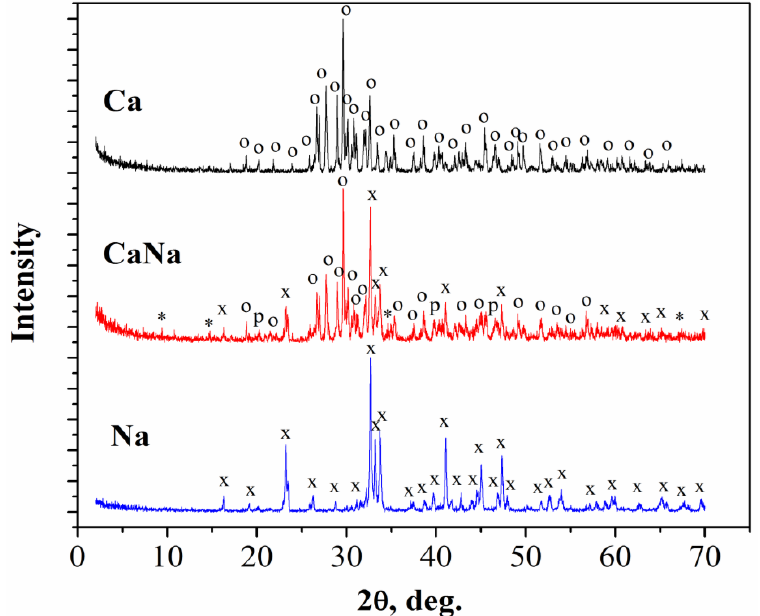
Figure 4. The XRD of ceramic samples based on cement-salt stone: Na (black-curve), CaNa (red-curve) and Ca (blue-curve) in the temperature of 900 ◦ C. x— β -CaNaPO 4 (PDF 29–1193); p—Na 2 CaP 2 O 7 (PDF 48–557); o— β -Ca 2 P 2 O 7 (PDF 9–346); *—Ca 10 Na(PO 4 ) 7 (PDF